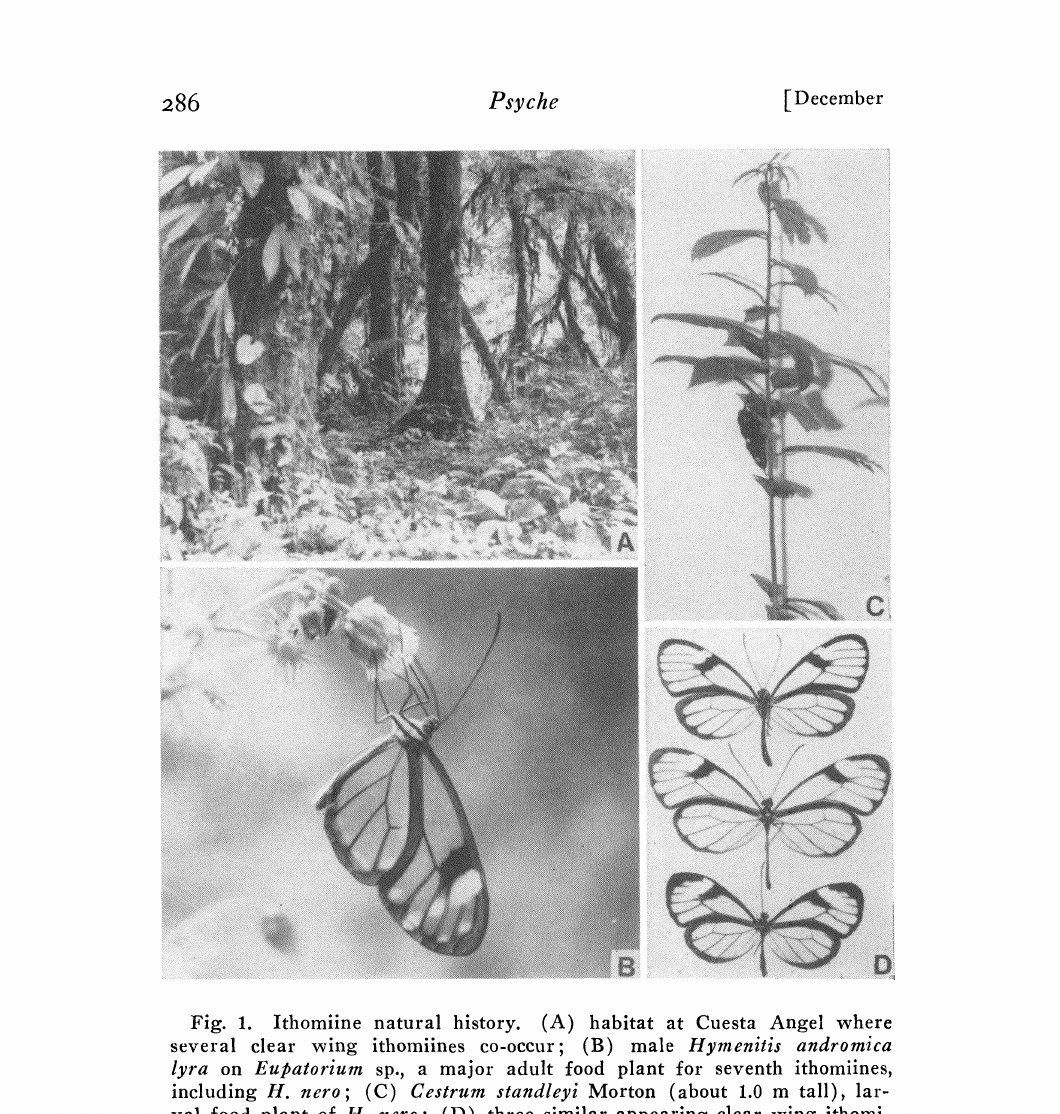
Fig. 1. Ithomiine natural history. (A) habitat at Cuesta Angel where several clear wing ithomiines co-occur; (B) male Hymenitis andromica lyra on Eupatorium sp., a major adult food plant for seventh ithomiines, including H. nero; (C) Cestrum standleyi Morton (about 1.0 m tall), lar- val food plant of H. nero; (D) three similar-appearing clear wing ithomi- ines co-occurring at Cuesta Angel, from top to bottom" Hymentiis nero, H. andromica lyra, and Pseudoscada utilla